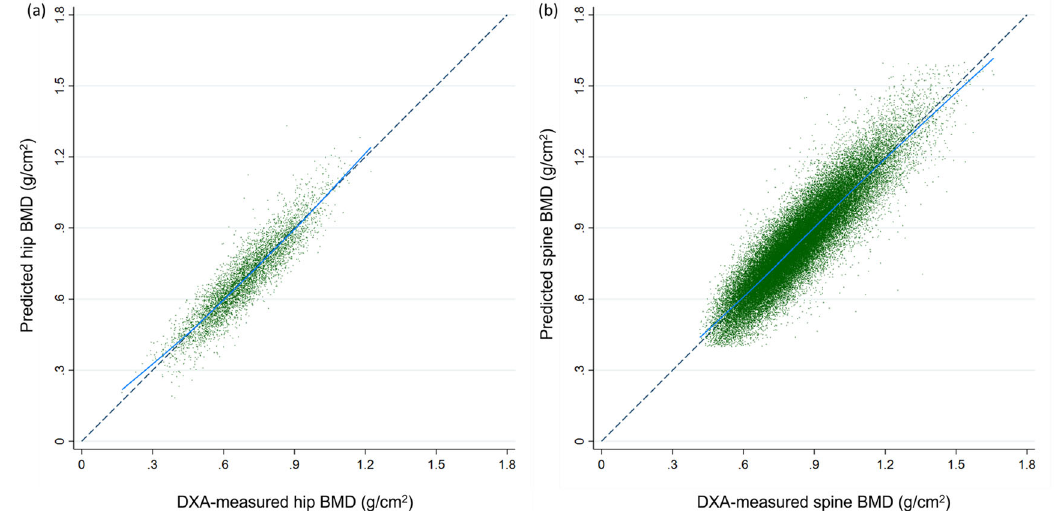
Fig. 2 The calibration plots for predicted-measured BMD. The calibration plots show predicted BMD values against DXA-measured BMD values for assessment of model performance. a Five thousand one hundred and sixty-four pairs of predicted-measured hip BMD (5164 patients), and b 57,662 pairs of predicted-measured lumbar vertebral BMD (18,175 patients). Each point represents a data pair of predicted and measure BMD. The points close to the diagonal line suggests good calibration.